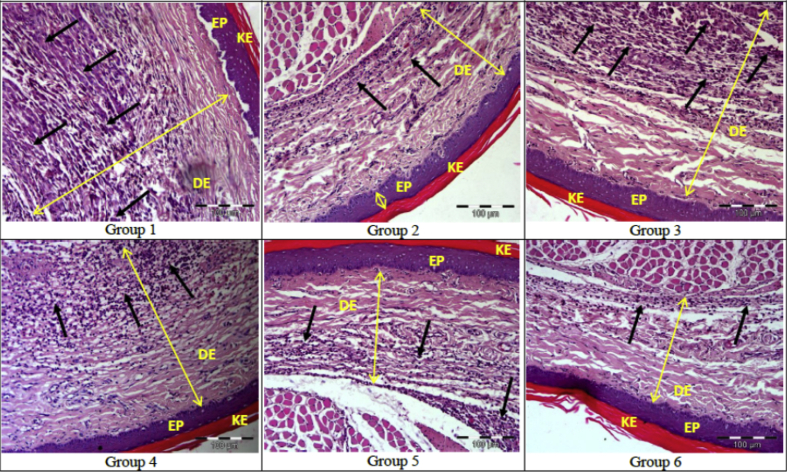
The micrographs of edematous paws of different treatment groups observed under 200x magnification. Black color arrow indicates the leukocyte infiltration to the dermis layer. The leukocytes are displayed as dark purple color. KE is defined as keratin layer, EP is defined as epidermis while DE is defined as dermis. The scale bar was 100 μm for every photograph taken. Group 1 pretreated with 2% Tween 20, Grourp 2 pretreated with 300 mg/kg Aspirin, Group 3, 4, 5 and 6 pretreated with 5 mg/kg, 10 mg/kg, 25 mg/kg and 50 mg/kg of E. cuneatum alkaloid leaf extract respectively.